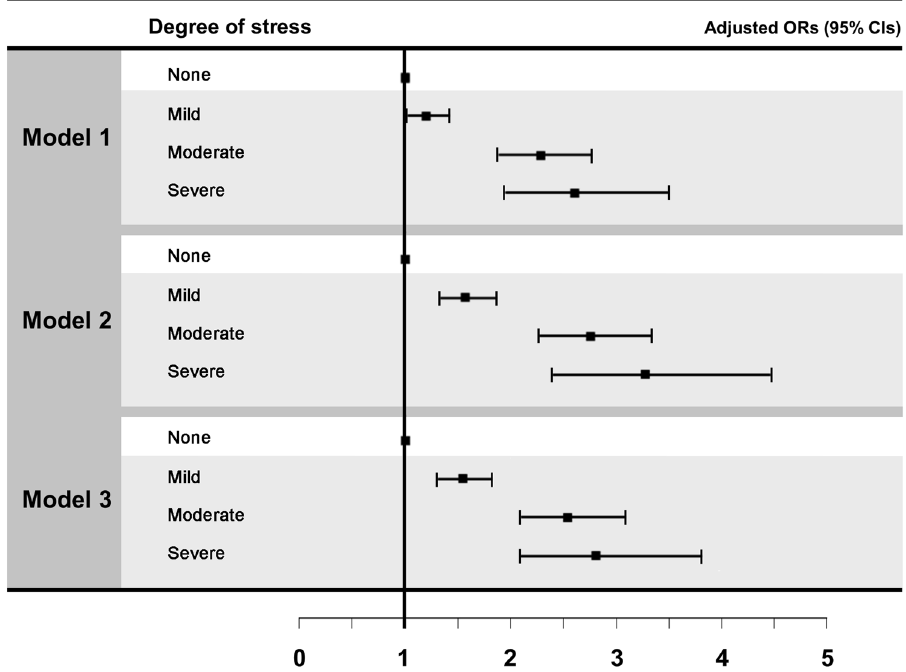
Figure 2. Odds ratio of degree of stress in participants with low back pain. Model 1, no adjustments for other variables; Model 2, adjustments for sex and age; and Model 3, adjustments for sex, age, and other environmental factors, such as obesity, sleep duration, smoking, alcohol consumption, education level, household income, occupation, physical activity, and comorbidities. CI confidence interval, OR odds